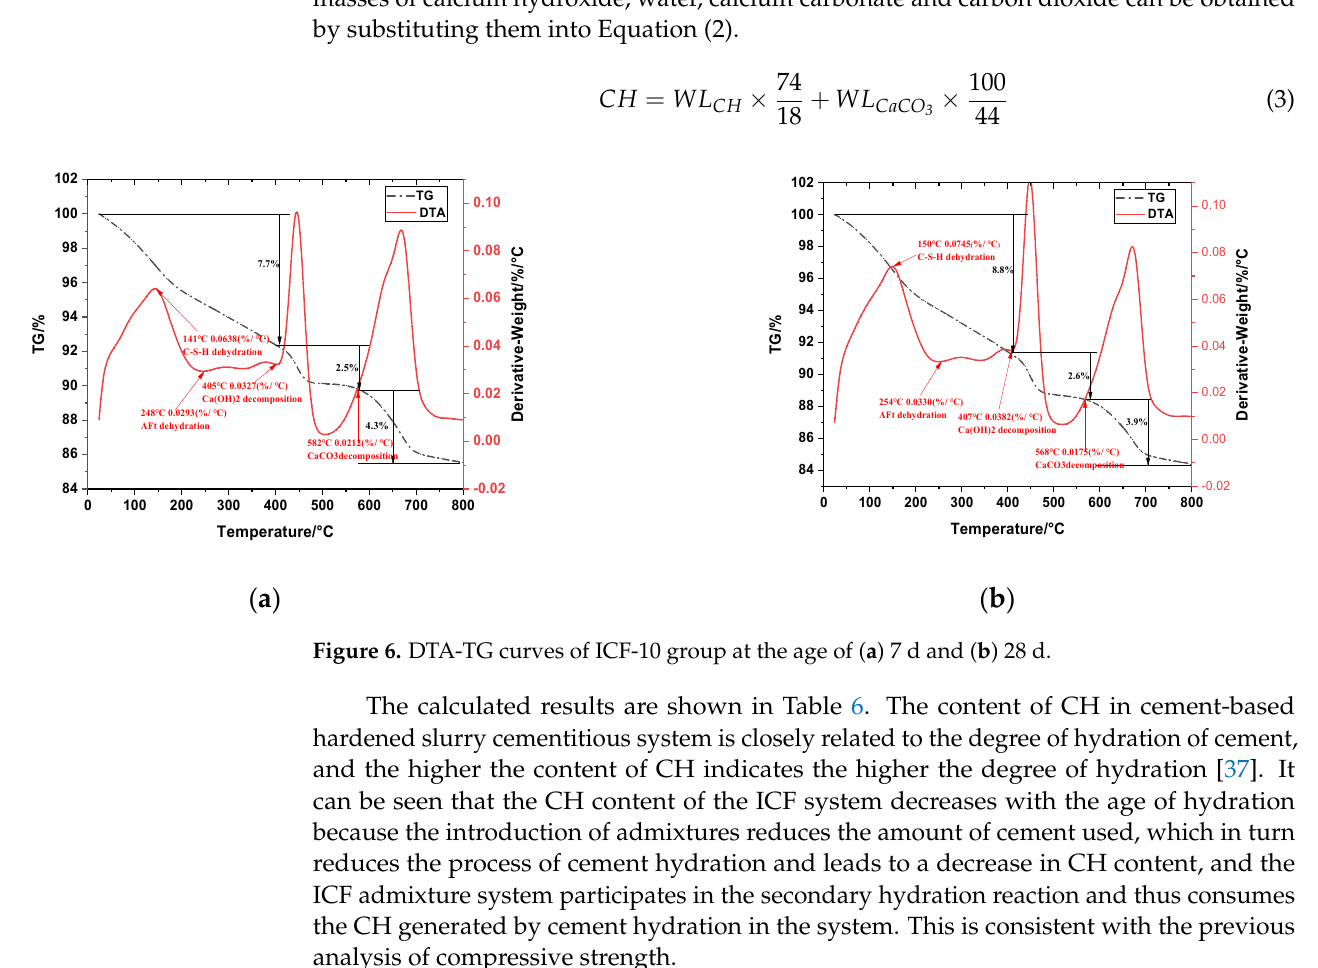
8 of 12 Figure 5. Compressive strength tests with different activator doping.